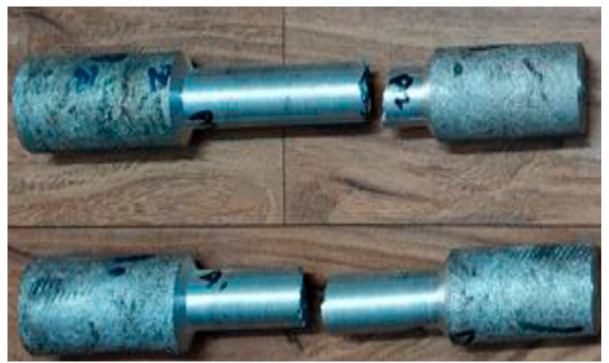
Figure 4. Tensile strength specimen image.